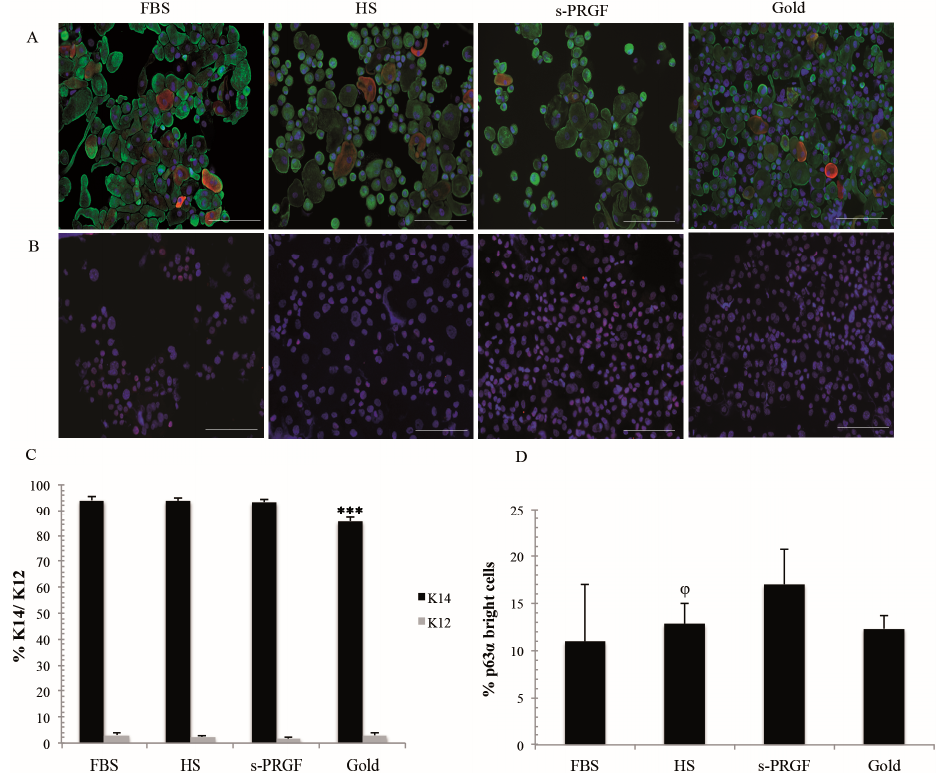
Figure 2. Protein expression profiles of several cell markers in LESCs obtained from explants and gold standard cultures treated with FBS or two di ff erent human sera: ( A ) Double immunostaining for K14 (green) and K12 (red) cytokeratins; ( B ) Immunostaining for p63 α ; ( C ) Percentage of K14 and K12 positive cells; ( D ) Percentage of p63 α bright cells. *** Indicates significant di ff erences between the gold standard culture and all the other treatments ( p < 0.001), and ϕ between FBS and the indicated treatment ( p < 0.05). Scale bar for fluorescence images, 100